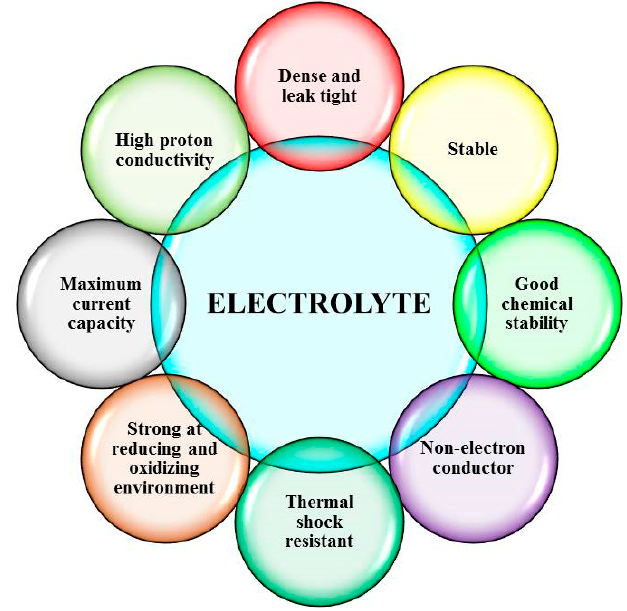
Figure 3. Properties of electrolytes.